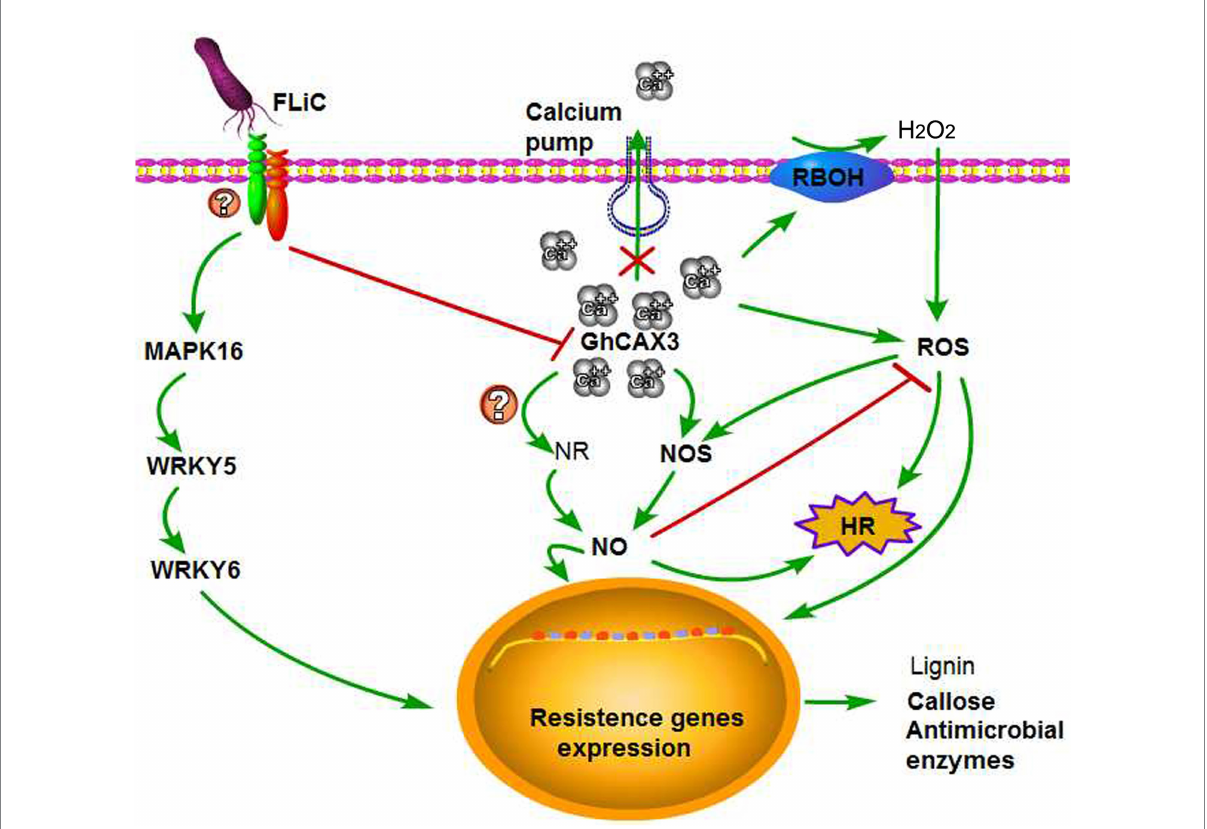
FIGURE 8 Possible explanation of the FLiC-induced resistance signaling pathway. FLiC increases the intracellular calcium ion content by inhibiting the expression of the calcium ion pump-regulating gene GhCAX3 , which in turn induces increases in the H 2 O 2 and NO contents and thereby improves the resistance of cotton to Verticillium